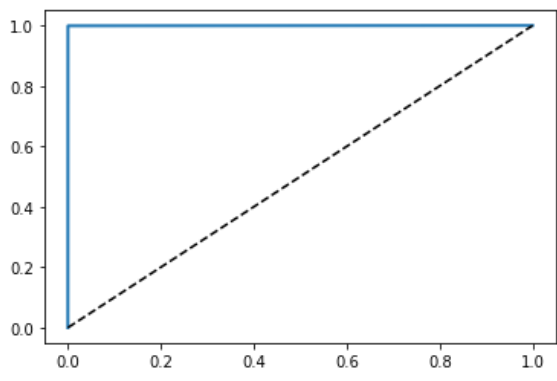
Figure 21. ROC after RF optimization.